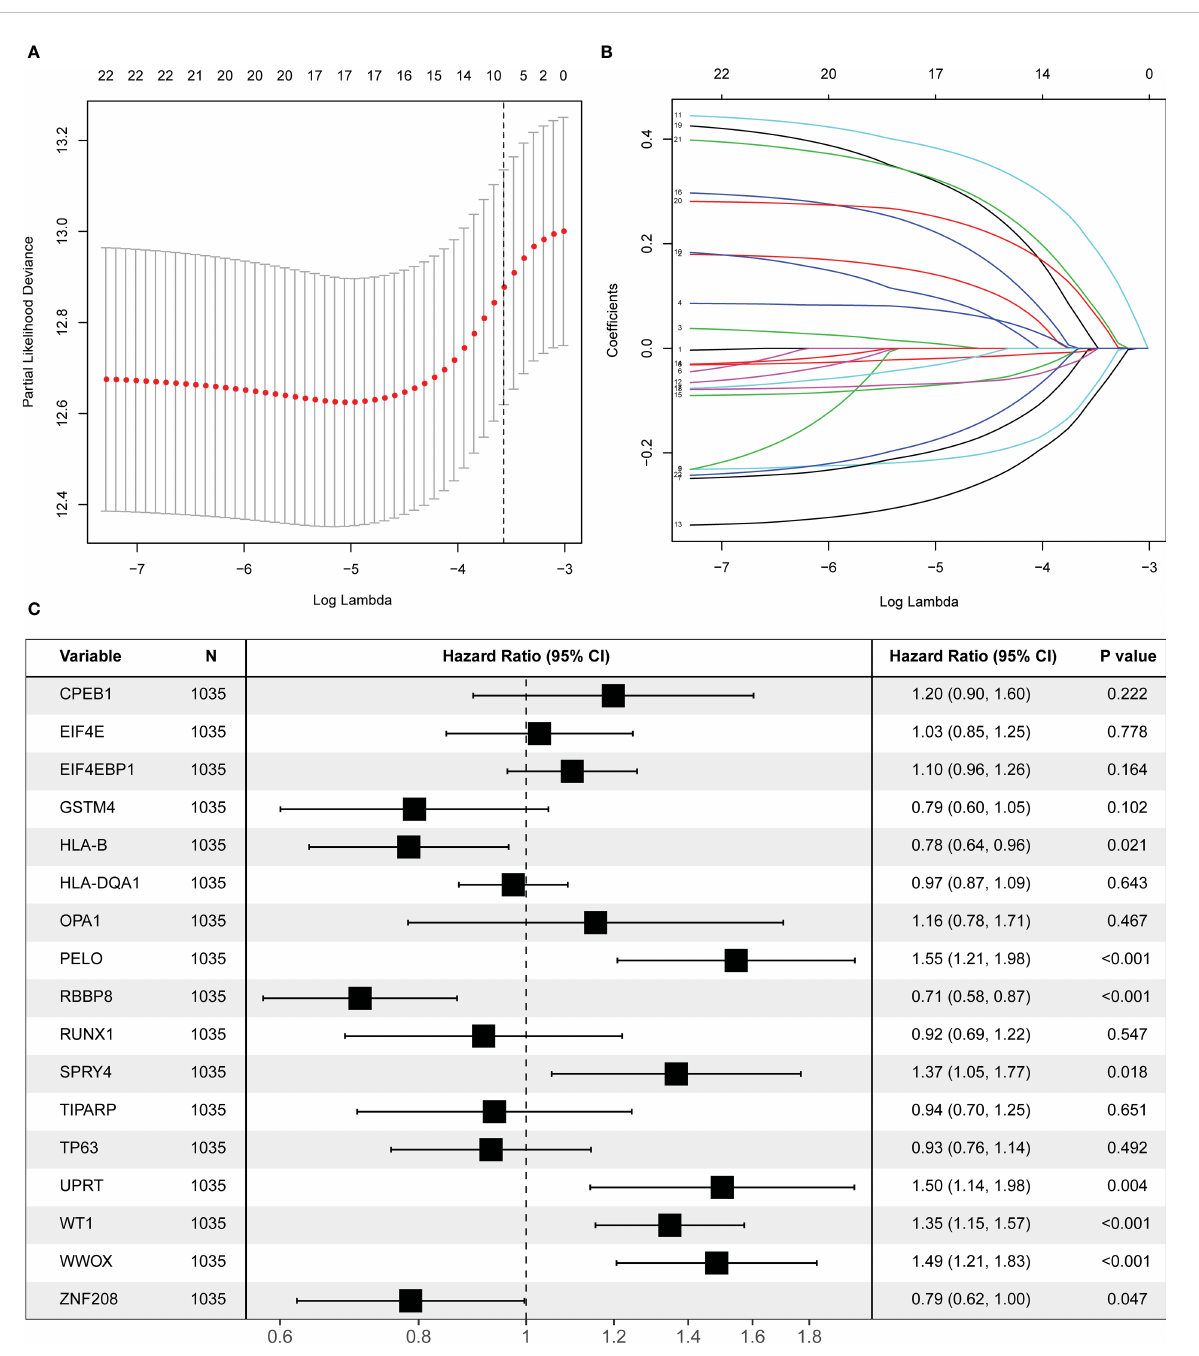
FIGURE 2 Screening and identi fi cation of prognostic ovarian ageing-related genes (OARGs) in the TCGA cohort. (A) Selection of the optimal candidate genes in the LASSO model. (B) LASSO coef fi cients of prognosis-associated OARGs, each curve represents a gene. (C) Forest plots showing results of univariate Cox regression analysis between the candidate OARGs expression and overall